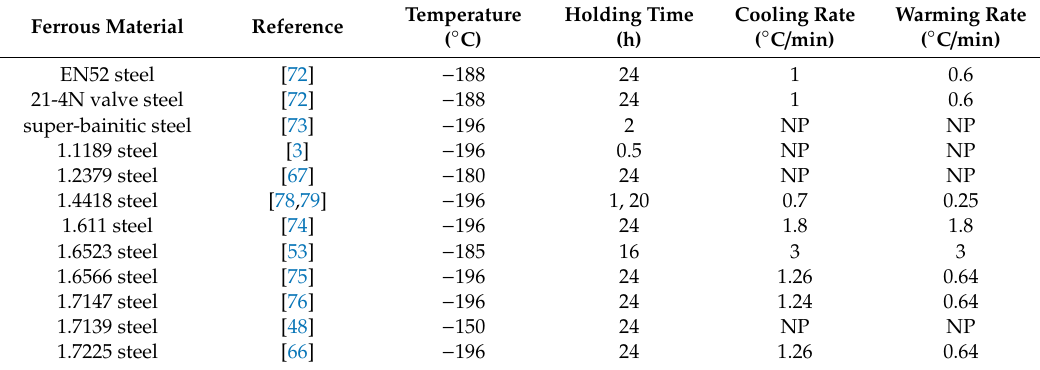
Table 1. Ferrous materials and deep cryogenic treatment (DCT) parameters from the literature. Ferrous